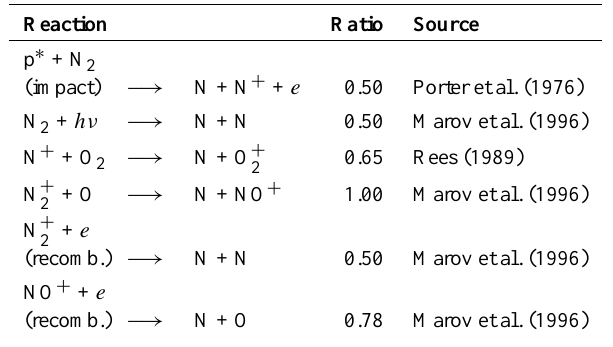
Table 2. The branching ratios for the reactions producing N( 2 D) Reaction Ratio Source